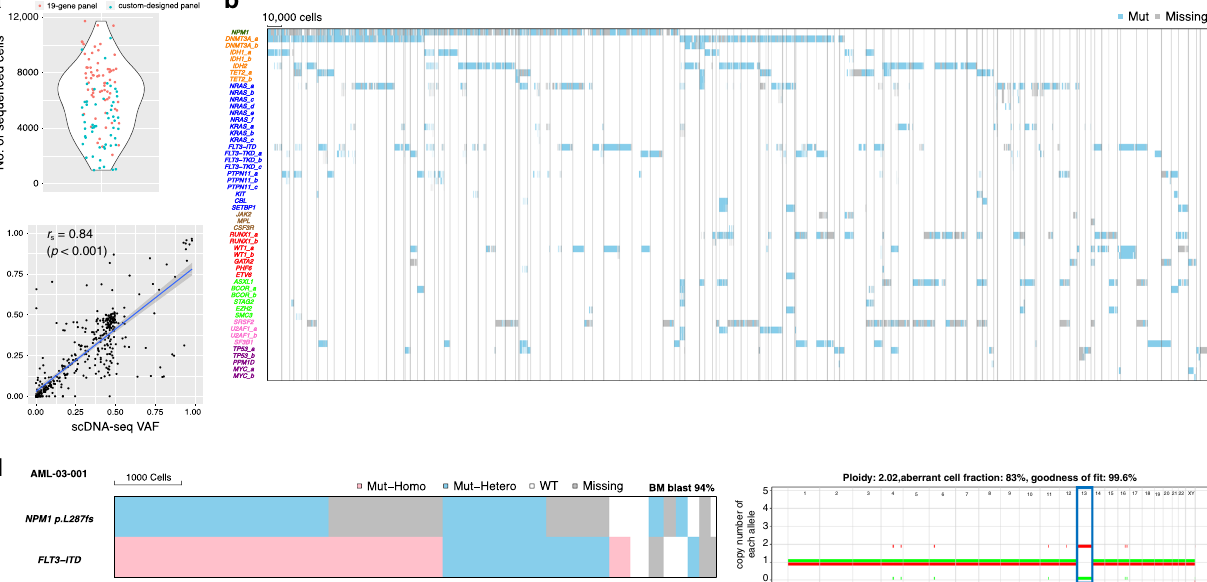
Fig. 1 The Genetic landscape of AML based on single-cell DNA sequencing. a Distribution of the number of total sequenced cells. Each point represents a sample from unique patients. b Somatic mutations in 735,483 cells from 123 AML patients detected by single-cell DNA sequencing (scDNA-seq). Each column represents a cell at the indicated scale, and cells from the same case are clustered together within the areas surrounded by the gray lines. Cells that were genotyped as being mutated or wild type for the indicated gene are colored in blue and white, respectively. Cells with missing genotypes are colored in gray. When one sample has multiple different mutations in the same gene, they were annotated differently (e.g., DNMT3A _a and DNMT3A _b). Mutated genes are colored based on the affected molecular pathway (nucleophosmin colored in green, DNA methylation in orange, RTK/RAS/MAP kinase pathway in blue, JAK-STAT pathway in brown, transcription factor in red, chromatin/cohesin in light green, splicing in pink, and apoptosis in purple). A total of 76,549 cells that were genotyped as wild type for all the variants screened are not shown. c Correlation of the variant allele fraction (VAF) from bulk- sequencing and scDNA-seq. The x -axis shows the VAF from scDNA-seq (scDNA-seq VAF). The y -axis shows the VAF from the bulk sequencing (bulk VAF). Each dot represents a detected variant. The line represents a linear regression line. The shaded area represents the 95% con fi dence intervals. d A representative case with highly homozygous variant involving copy-neutral loss of heterozygosity (CN-LOH). Heat map (left) shows the genotype of each sequenced cell for each variant, with clustering based on the genotypes of driver mutations. Each column represents a cell at the indicated scale. Cells with homozygous mutation, heterozygous mutation, and wild-type cells are indicated in red, blue, and white, respectively. Cells with missing genotypes are indicated in gray. The allele counts distribution is shown to the right. The allele count is shown on the vertical axis, and the chromosomes are shown on the horizontal axis. Chromosome 13 involving highly homozygous FLT3 -ITD is highlighted with a blue rectangle. Mut-Homo homozygously mutated, Mut- Hetero heterozygously mutated, WT wild type, Missing missing